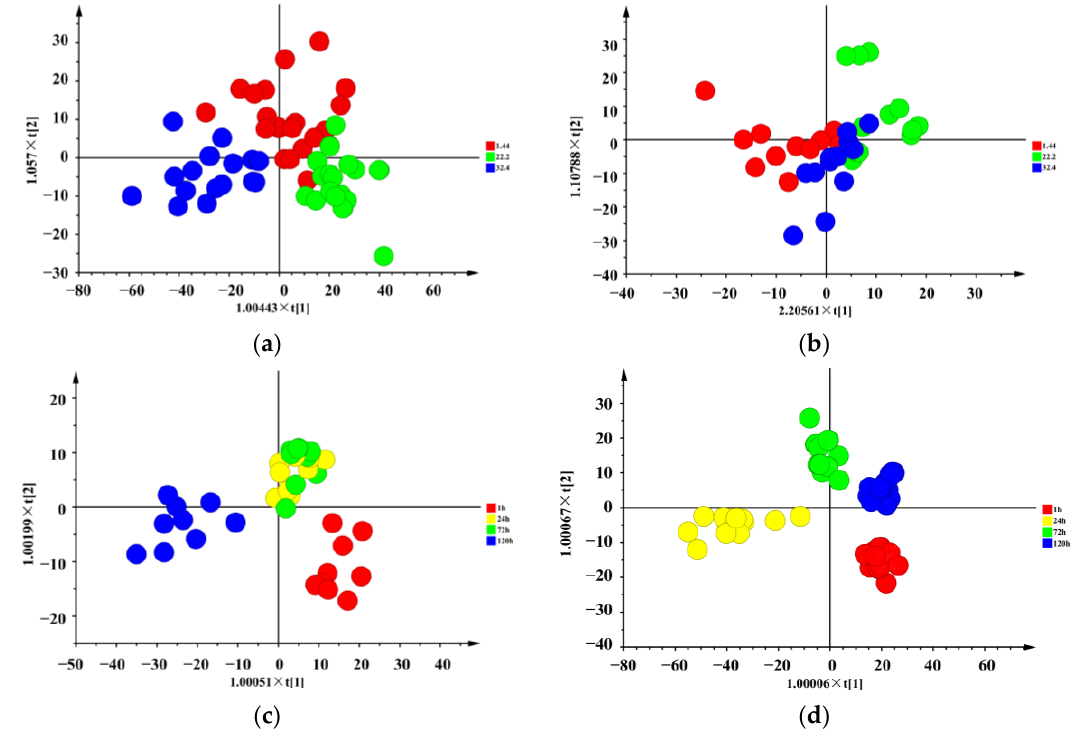
Figure 1. OPLS-DA score plots of volatile compounds and non-volatile compounds in raw meat at different chilling rates and different refrigeration times. ( a ) OPLS-DA score plot of volatile compounds at different chilling rates. ( b ) OPLS-DA score plot of non-volatile compounds at different chilling rates. ( c ) OPLS-DA score plot of volatile compounds at different refrigeration times. ( d ) OPLS-DA score plot of non-volatile compounds at different refrigeration times.